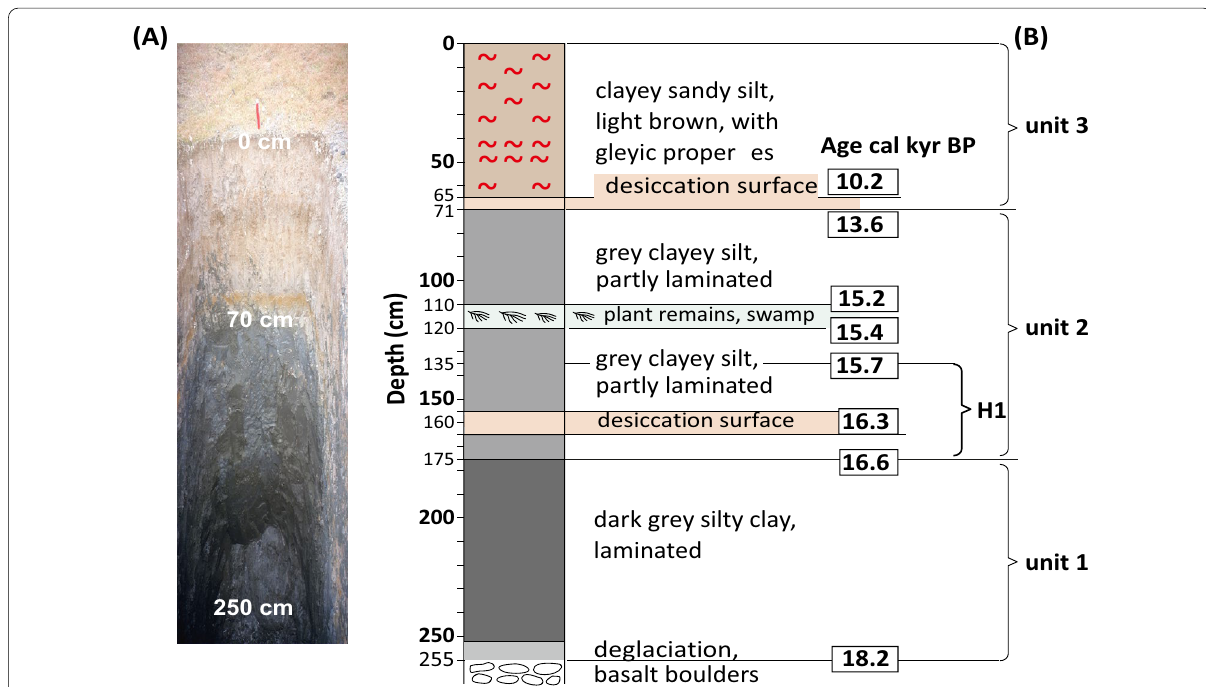
Fig. 2 Stratigraphy and photo of the studied profile. A Photo of the B4 profile; the red pocketknife (10 cm) serves as scale. B Stratigraphy of the sediments in profile B4, divided in units 1–3, based on morphological features and calibrated radiocarbon ages (see Fig. 3; Table 1; YD Dryas, H1 Heinrich Event =